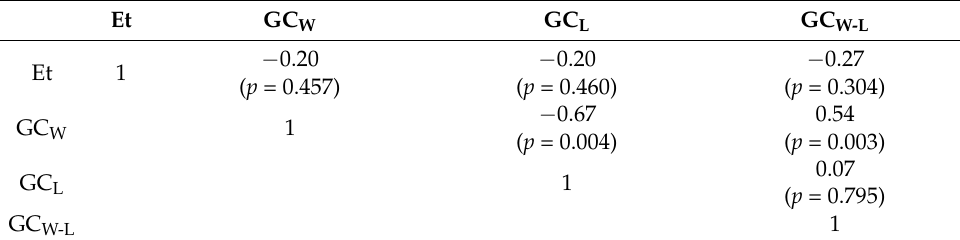
Table 4. Correlation between soil erosion and ground cover of the maize cultivation plots (n =